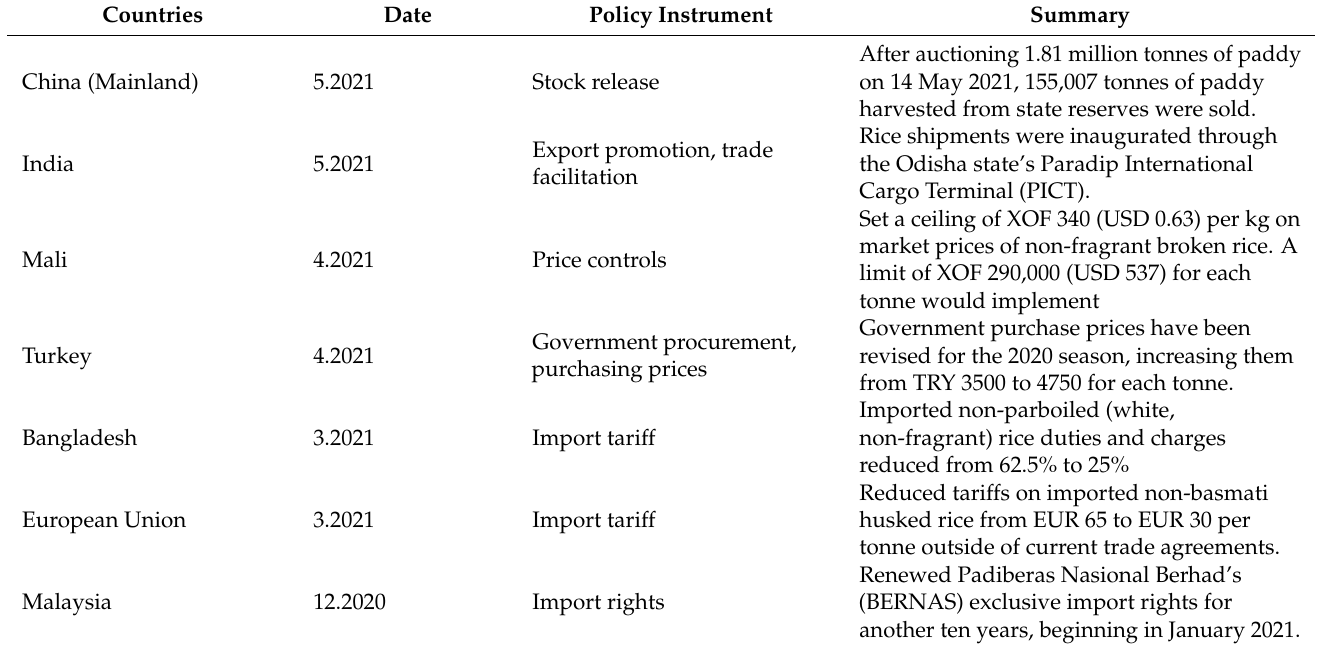
Table 7. Current policies development